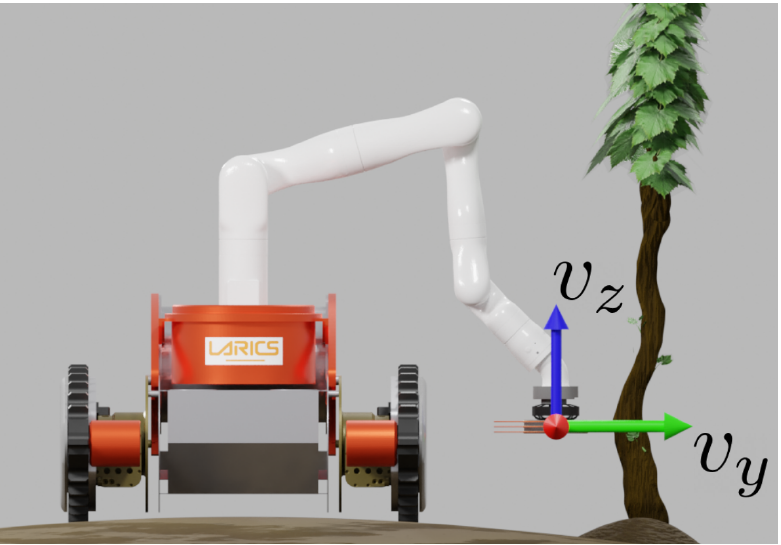
Figure 7. The velocity of the robot arm end-effector is controlled to achieve compliant plant trunk shape